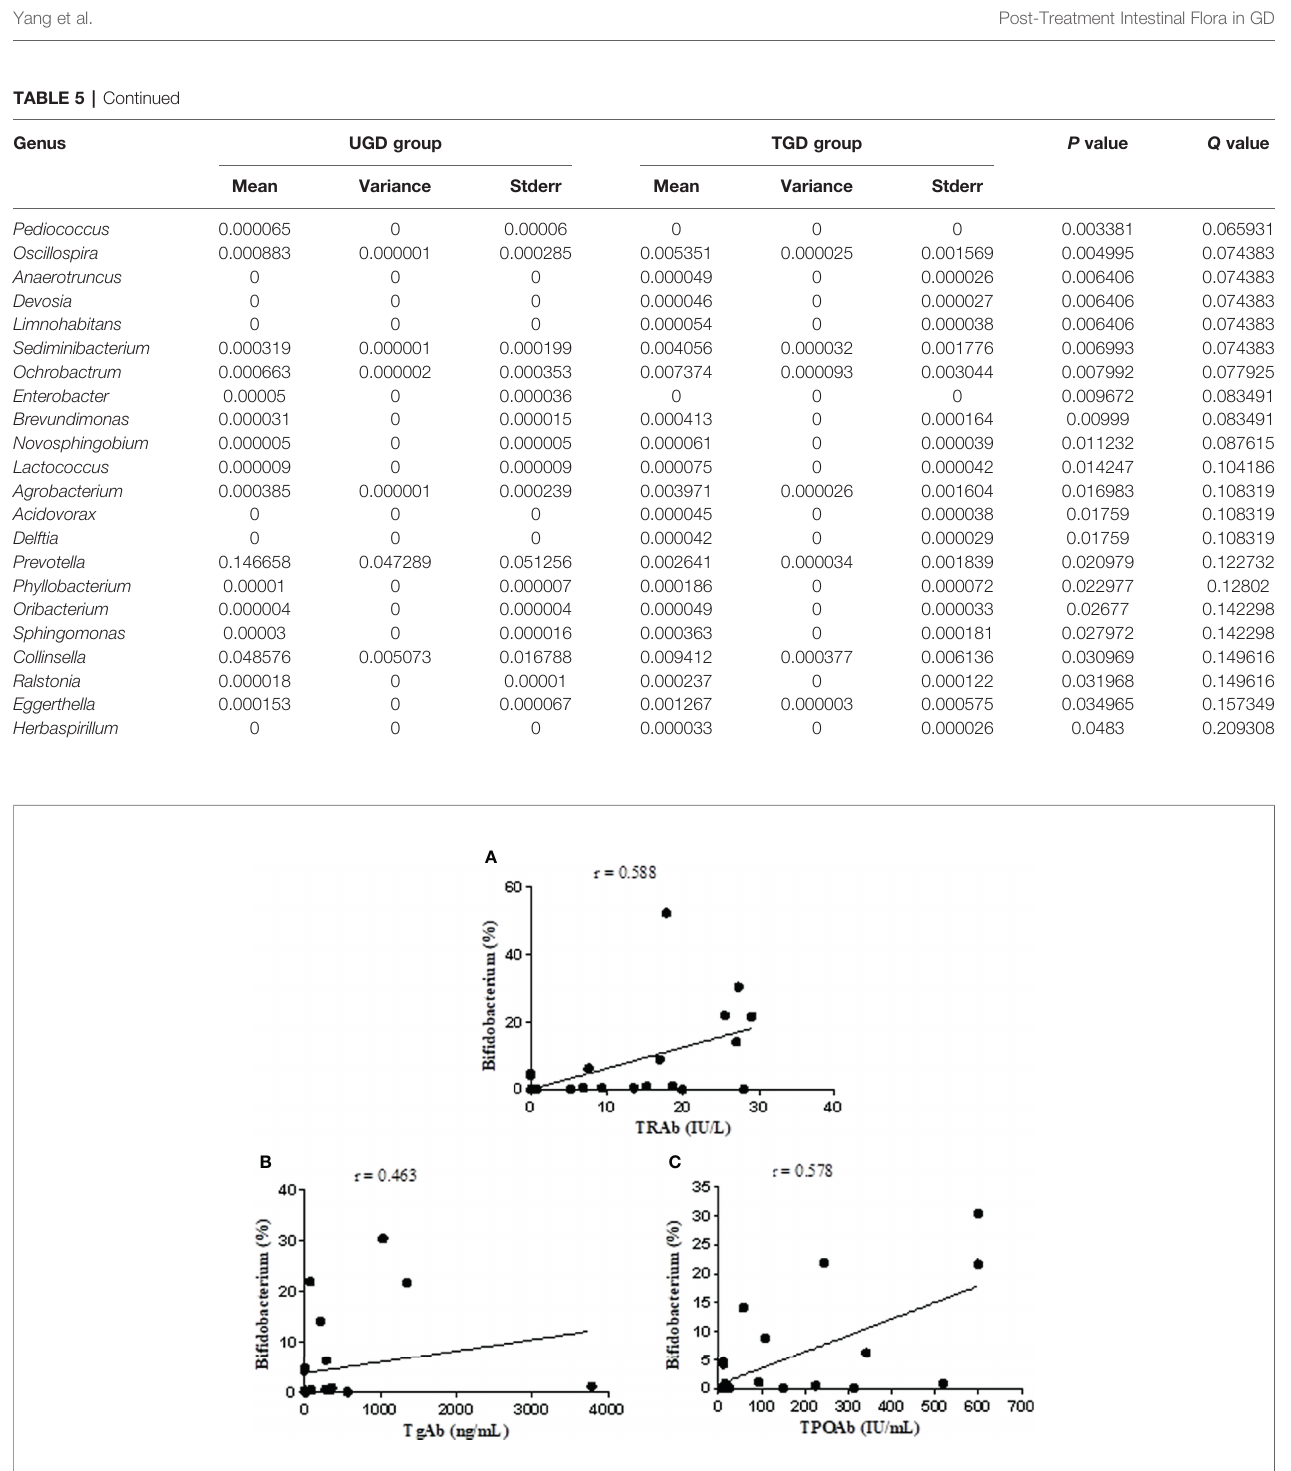
FIGURE 7 | Correlation analysis of Bi fi dobacterium with TRAb, TgAb, and TPOAb based on the data from the NC and UGD groups. (A) Bi fi dobacterium and TRAb. (B) Bi fi dobacterium and TgAb. (C) Bi fi dobacterium and